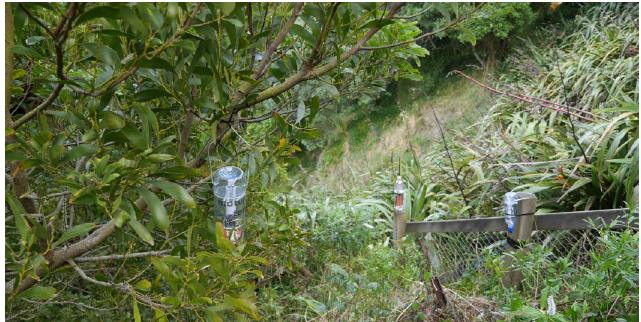
Figure 2: Moturoa Transmissions installation showing temperature sensor probe suspended left, ec-sensor attached to fencepost on the right and the base station further in the